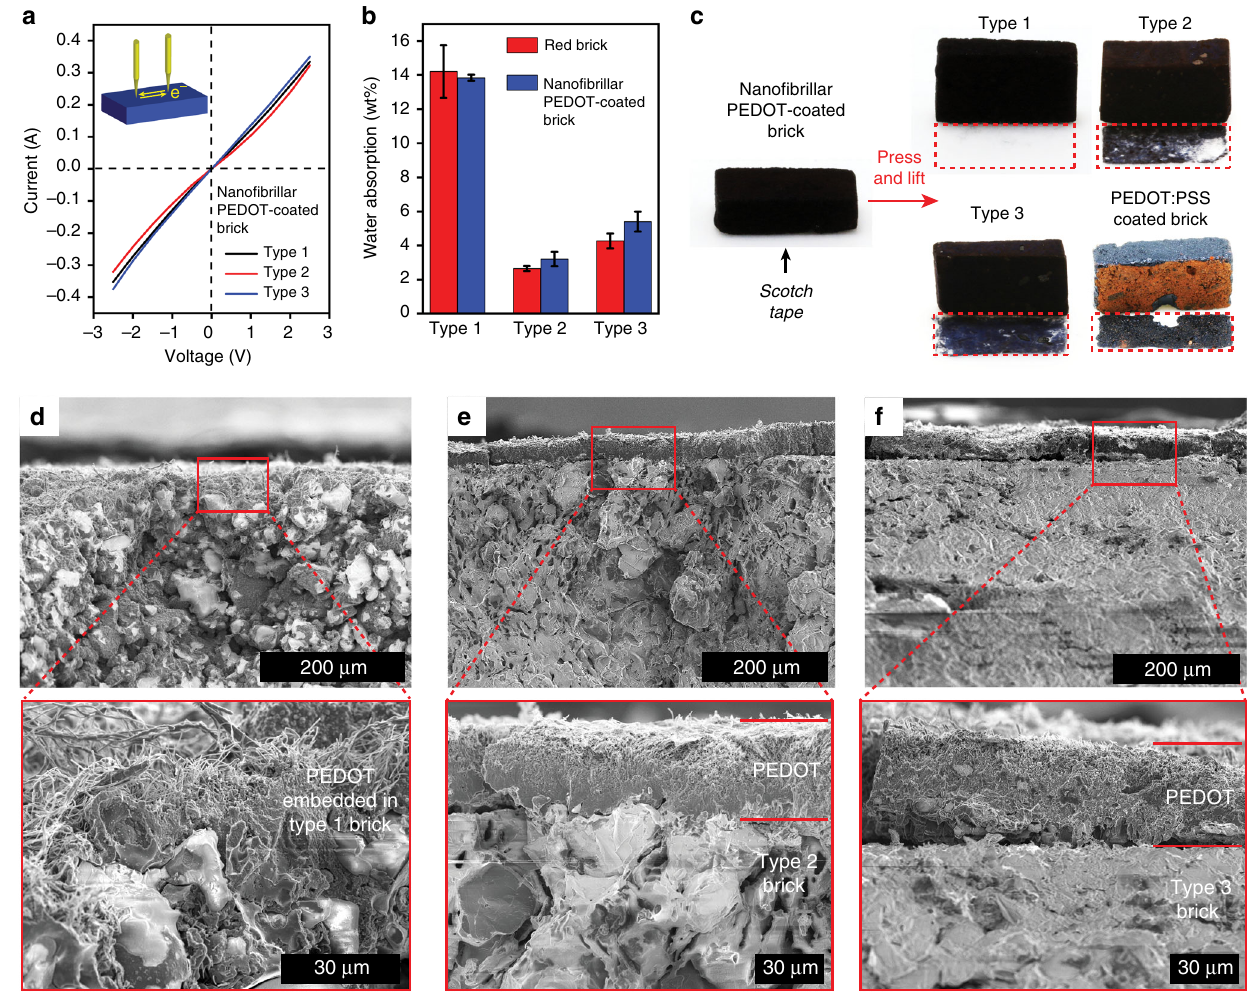
Fig. 3 Analysis of PEDOT coatings on various bricks. a Linear current – voltage curves show ohmic behaviors of nano fi brillar PEDOT coatings possessing comparable resistances. b Water absorption experiments on bricks enables studying their open pore structure and all bricks show insigni fi cant changes in water absorption after PEDOT coatings with type 1 brick absorbing the most water due to a higher porosity. c A nano fi brillar PEDOT coating exhibits superior adhesion on type 1 brick versus other types during Scotch tape tests. Unfortunately, the commercial product PEDOT:poly(styrene sulfonate) delaminates completely after coated on type 1 brick. d Cross-sectional scanning electron micrographs show the embedded PEDOT network in type 1 brick leading to robust PEDOT adhesion. Type 2 ( e ) and type 3 ( f ) bricks show distinct boundaries between PEDOT and brick that are prone to